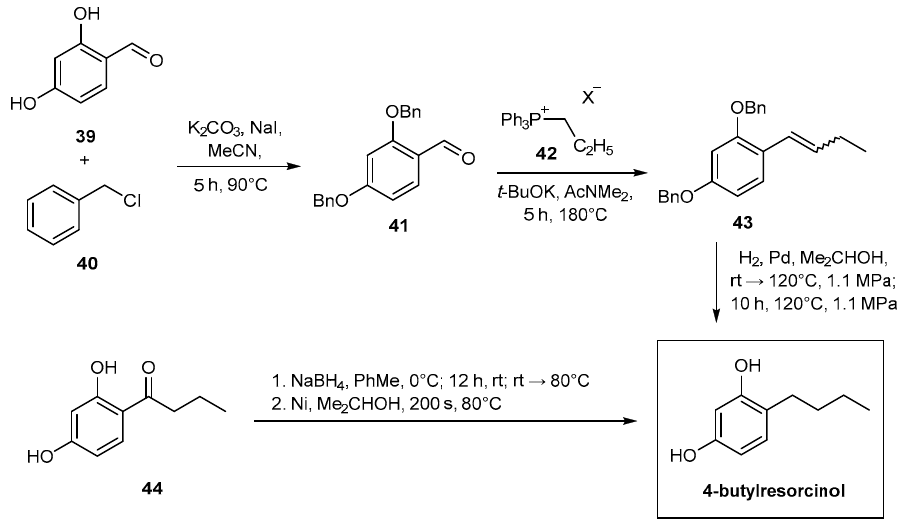
Scheme 7. Synthesis of 4-butylresorcinol. Adapted from